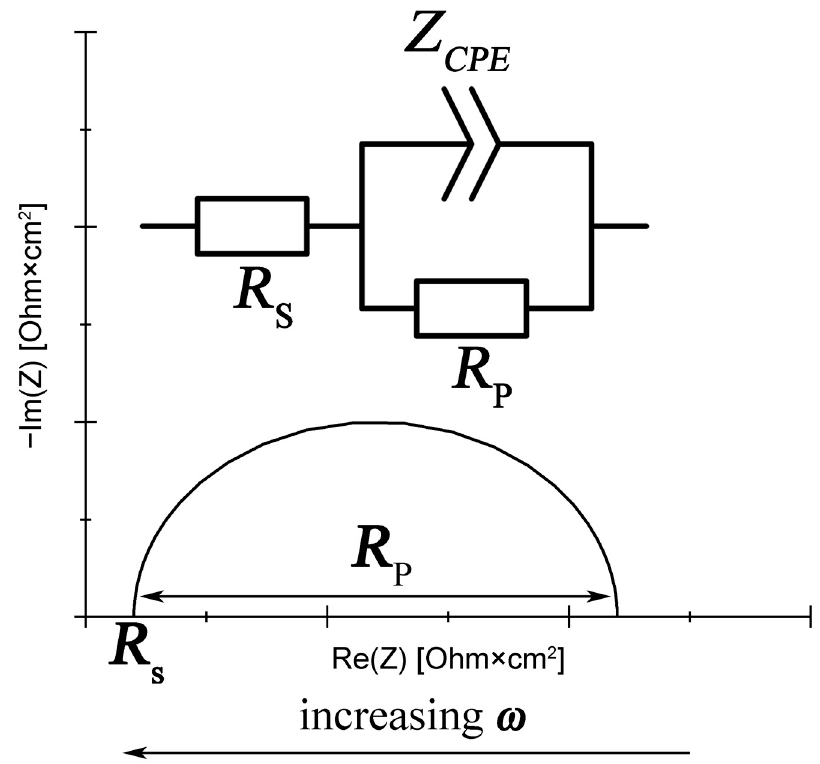
Figure 10. Equivalent circuit for the described corrosion